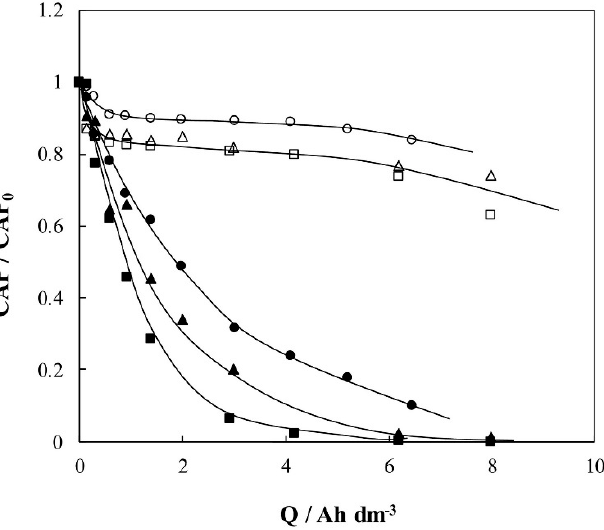
Figure 8. Evolution of chloramphenicol as a function of the applied electric charge during the elec- trochemical oxidation of 100 mg dm − 3 CAP in urine media. Current density: ( ■ , □ ) 1.25 mA cm − 2 ; ( ▲ , ∆ ) 2.5 mA cm − 2 ; ( ● , ○ ) 5 mA cm − 2 . Anodic material: (black symbols) BDD; (white symbols) MMO. Reprinted with permission from ref [90]. Copyright 2020 Elservier.